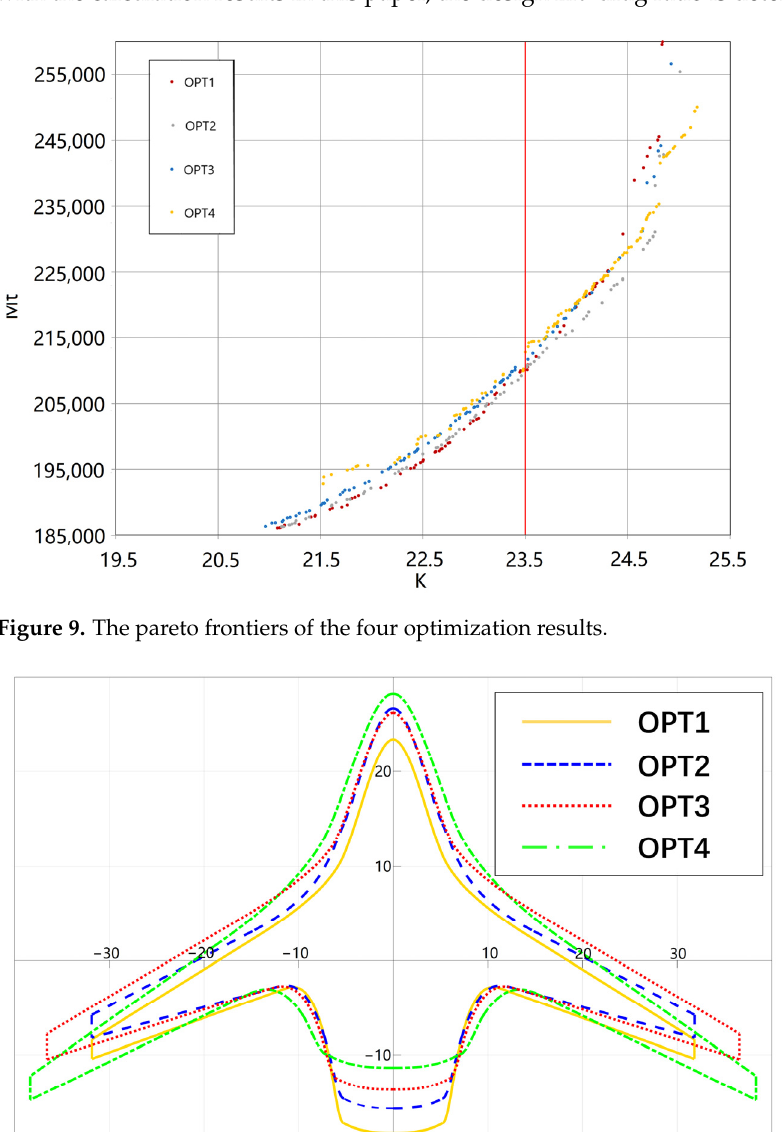
Figure 10. Planform of the configuration